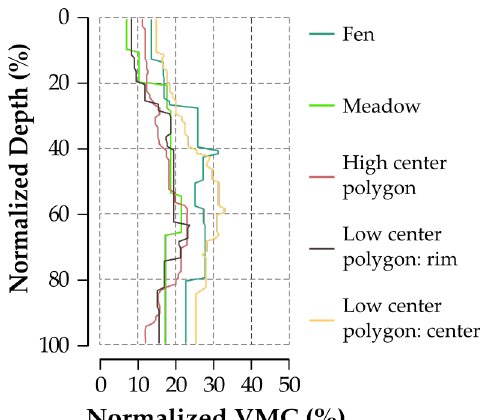
Figure 4. The mean Volumetric Moisture Content (VMC) for each land cover class normalized by the Active Layer Depth (ALD). The y-axis presents the normalized depth relative to the ALD (Figure S3). Table 5. Vegetation height in centimeters grouped by land cover class. Vegetation height classes